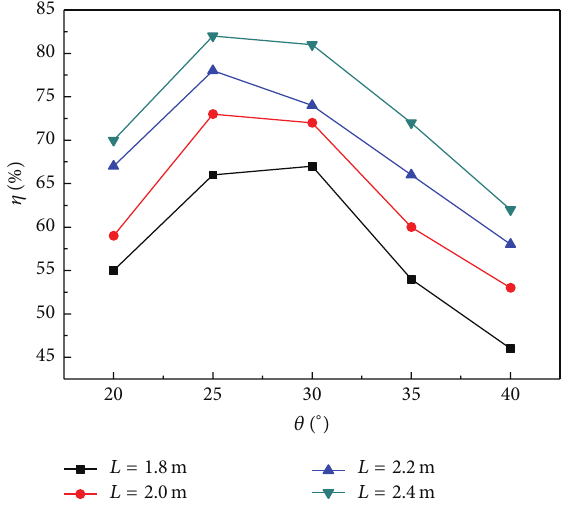
Figure 6: Effect of inclination angle on the sieving efficiency.